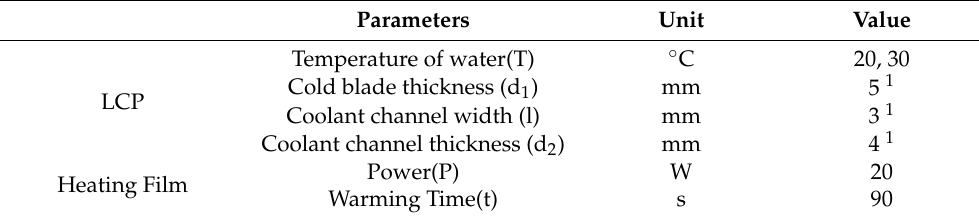
Figure 6. Voltage ( left ) and temperature curve ( right ) of 2C discharge at different heating times: ( a ) Without insulation; ( b ) With insulation conditions. Table 3. Heating